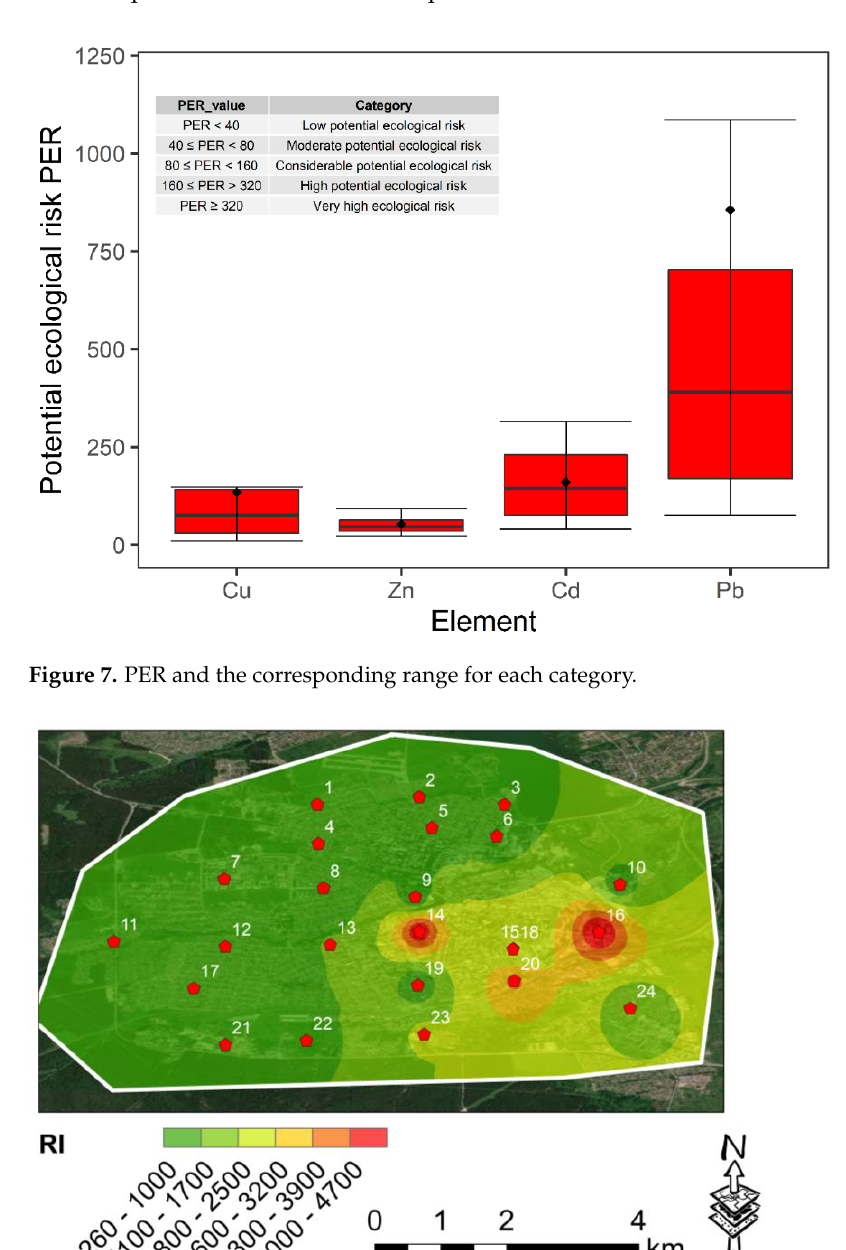
Figure 6. The distribution of the total pollution index (TPI).